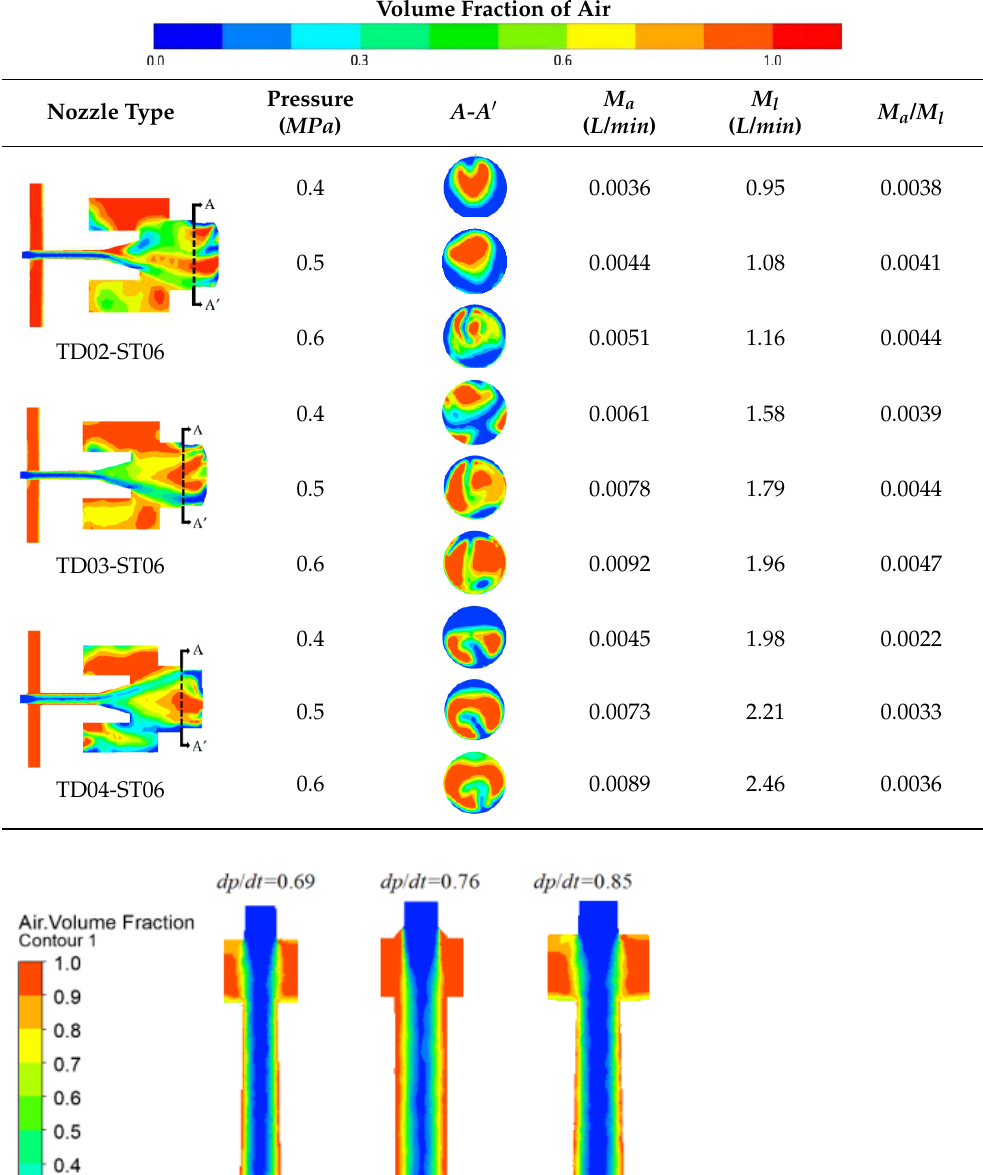
Table 2. Volume fraction cloud results of air in AIN.